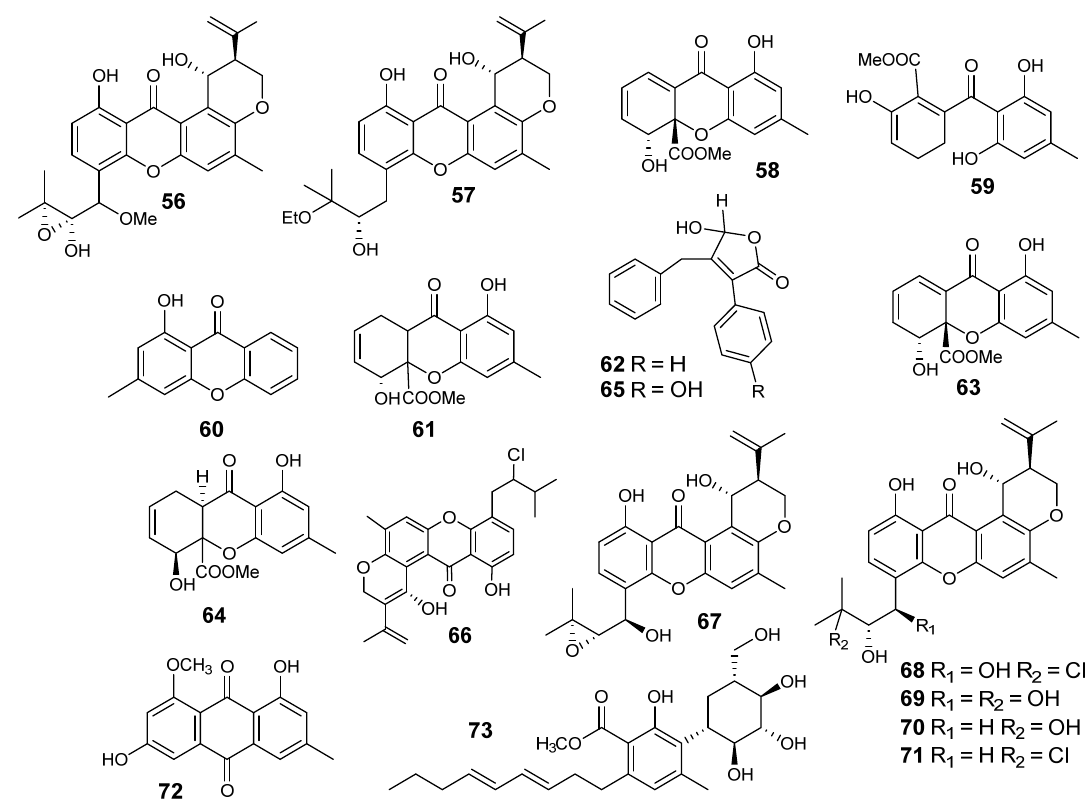
Figure 4. Structures of compounds 56–73 .